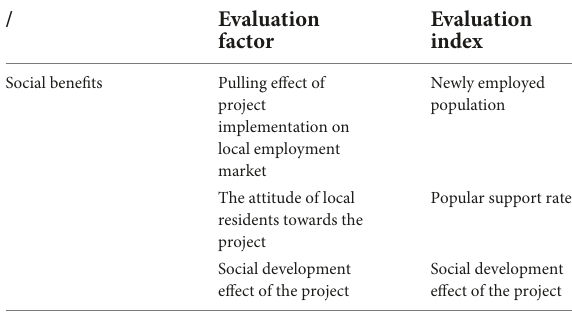
TABLE 9 Social benefit evaluation factors and evaluation indexes Evaluation factors.